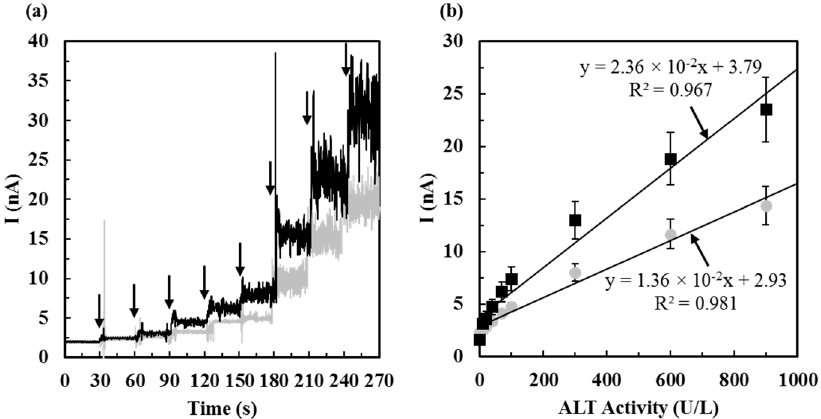
Figure 6. ( a ) ALT current responses corresponding to ALT activities (from 0 U/L, 10 U/L, 20 U/L, 40 U/L, 70 U/L, 100 U/L, 300 U/L, 600 U/L, to 900 U/L) of biosensors tested by Method 2 after one day of storage at 4 °C ( ━ gray line ) and − 20 °C ( ━ black line ). The arrows indicate the timing of ALT additions; ( b ) Calibration curves of ALT biosensors ( N = 10) tested by Method 2 after one day of storage in the refrigerator at 4 °C ( ● ) and − 20 °C ( ■ ).